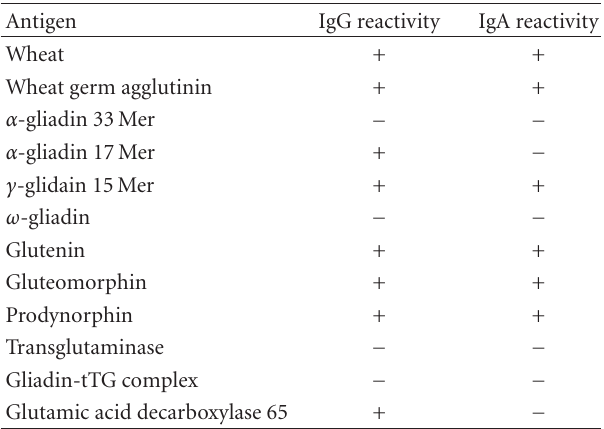
Table 1: Results from an array of wheat and enzyme